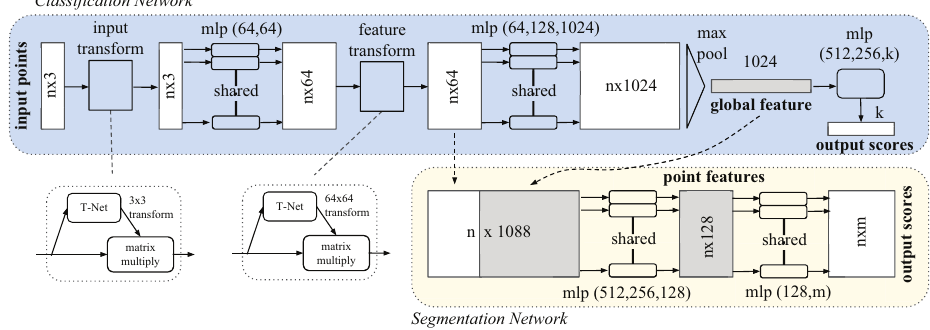
Figure 1. PointNet architecture. Reproduced from [46], with permission from publisher Hao Su,